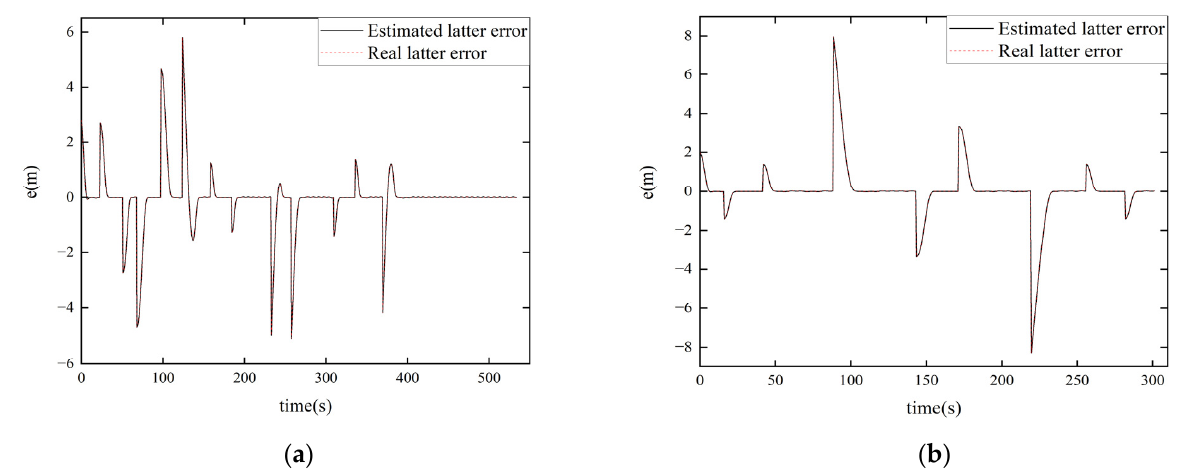
Figure 8. Estimated versus actual values of designed LESO for paths 1 and 2: ( a ) estimated versus actual values for paths 2; ( b ) estimated versus actual values for paths 2.